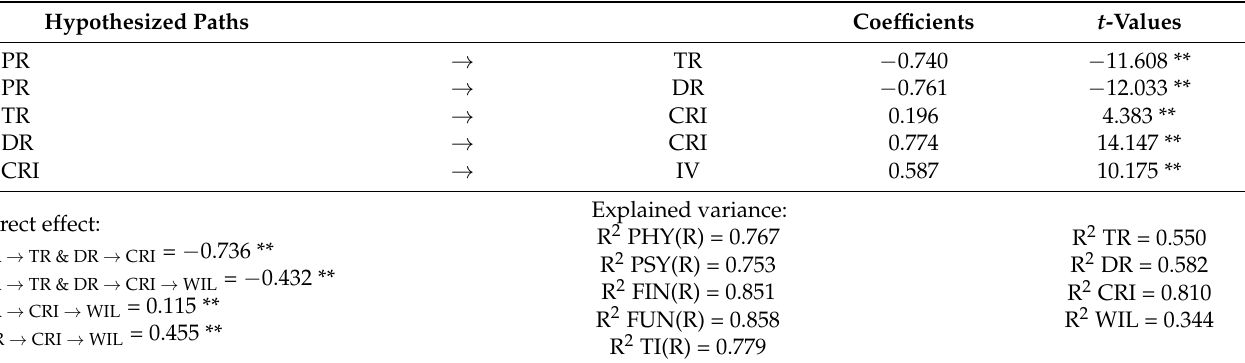
Table 2. Structure model